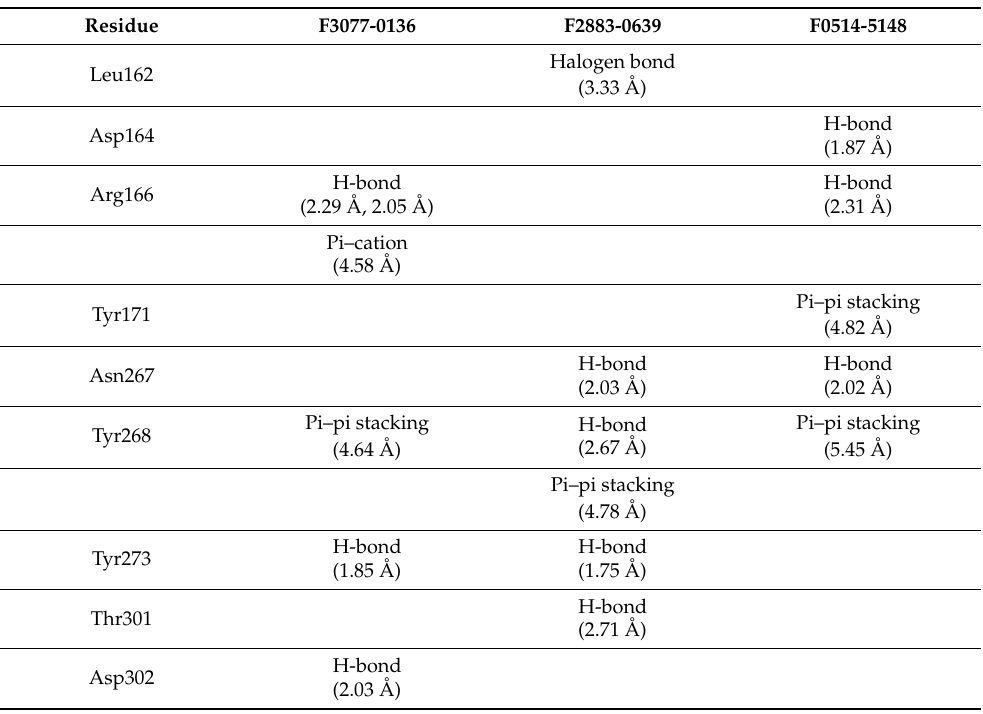
Table 2. The interactions between the top three compounds and the residues of SARS-CoV-2 PL pro and their distances (H-bond: hydrogen bond).